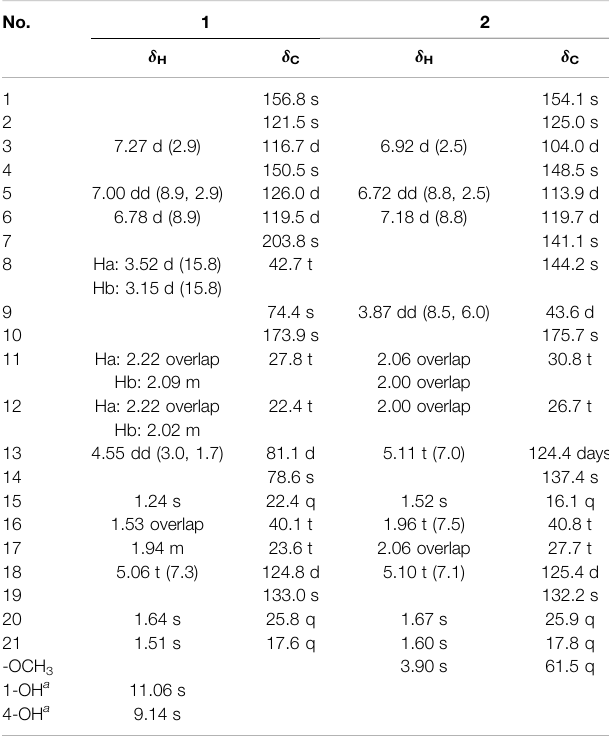
TABLE 1 | 1 H (600 MHz) and 13 C NMR (150 MHz) data of 1 and 2 in methanol- d 4 ( δ in ppm, J in